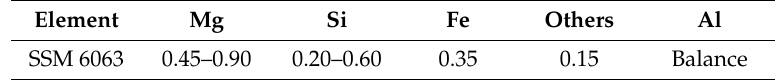
Figure 1. A globular microstructure of base SSM 6063 aluminum alloys. Table 1. Chemicals properties of the base semi-solid-metal (SSM) 6063 aluminum alloy used in this experiment